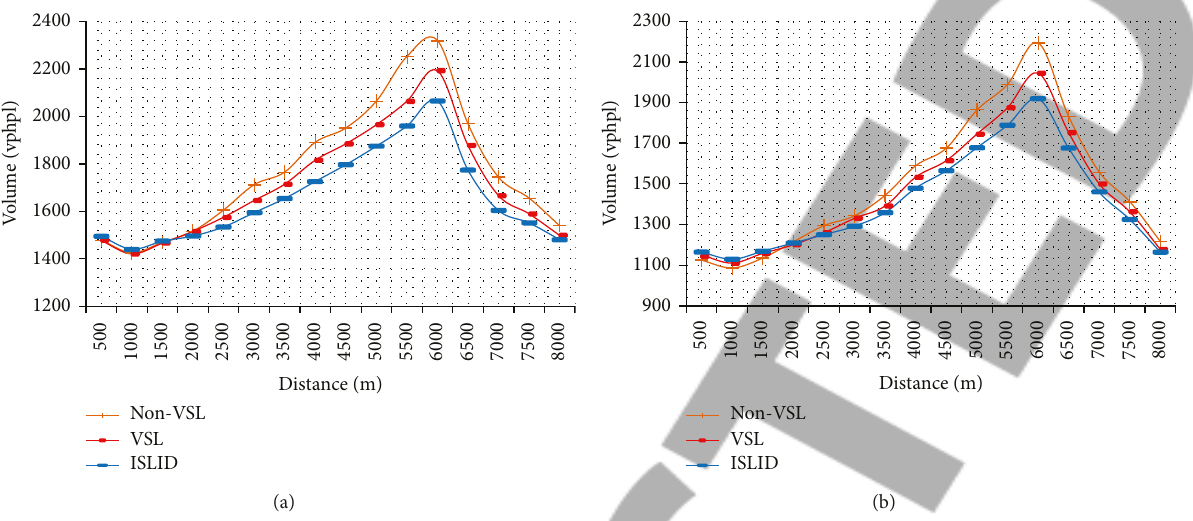
Figure 17: (a) Impacts of Non-VSL, VSL, and IASLD on average volume of vehicles in incident occurrence scenario under the dry condition. (b) Impacts of Non-VSL, VSL, and IASLD on average volume of vehicles in incident occurrence scenario under the wet condition.